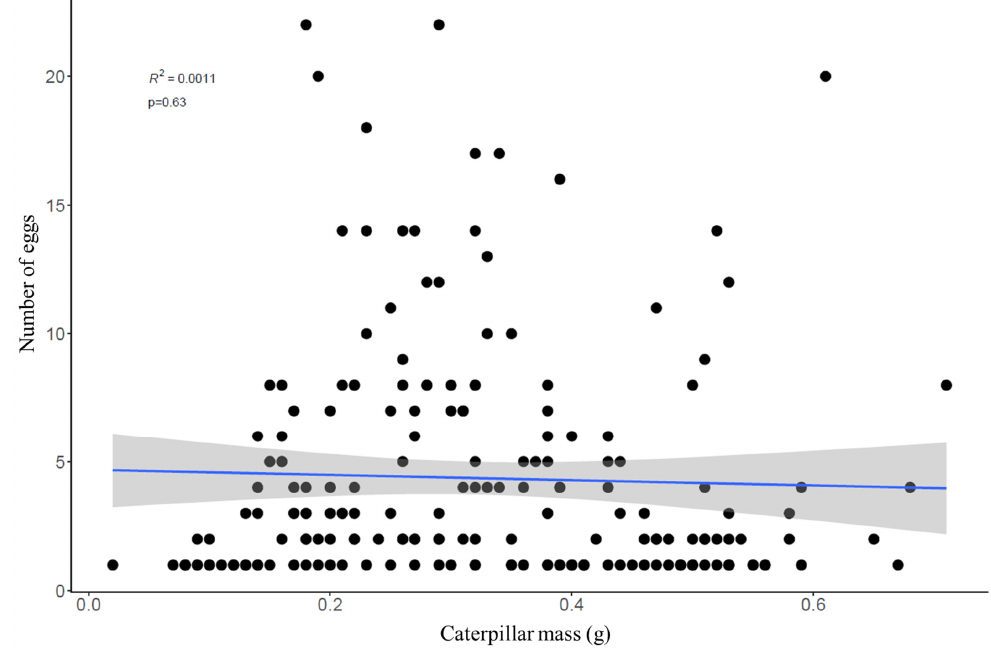
Figure 4. Scatterplot showing the relationship between the caterpillar weight and the number of tachinid eggs. The blue line indicates the linear model and its standard error (grey fill).